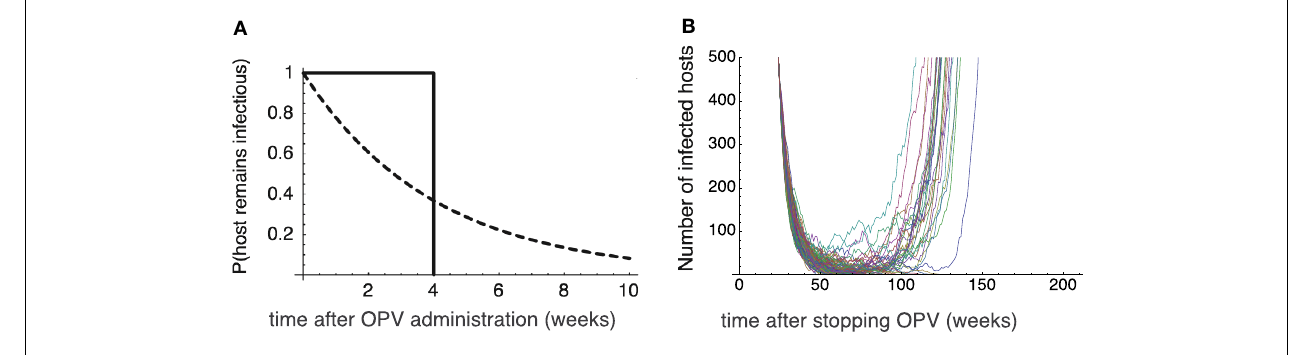
distribution of the infectious period.The time change in the number of virus infected hosts since OPV is stopped.Twenty-six out of 100 runs never go to extinction, and cause outbreaks.The emergence of virulent virus occurs after 50–60weeks after the secession of OPV.The parameters